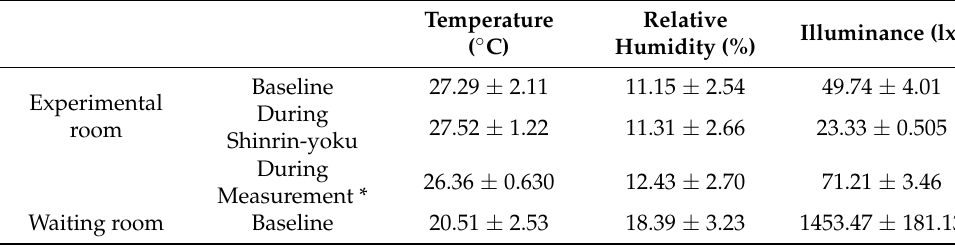
Table 2. Temperature, relative humidity, and illumination in experimental and waiting